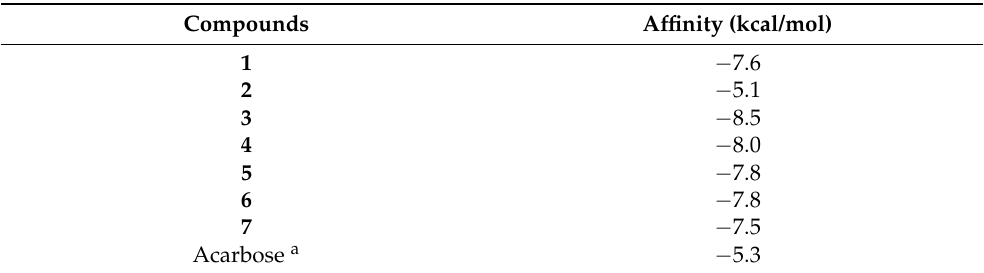
Table 8. Binding energies of active components and acarbose with α -glucosidase from Saccharomyces cerevisiae calculated in silico.